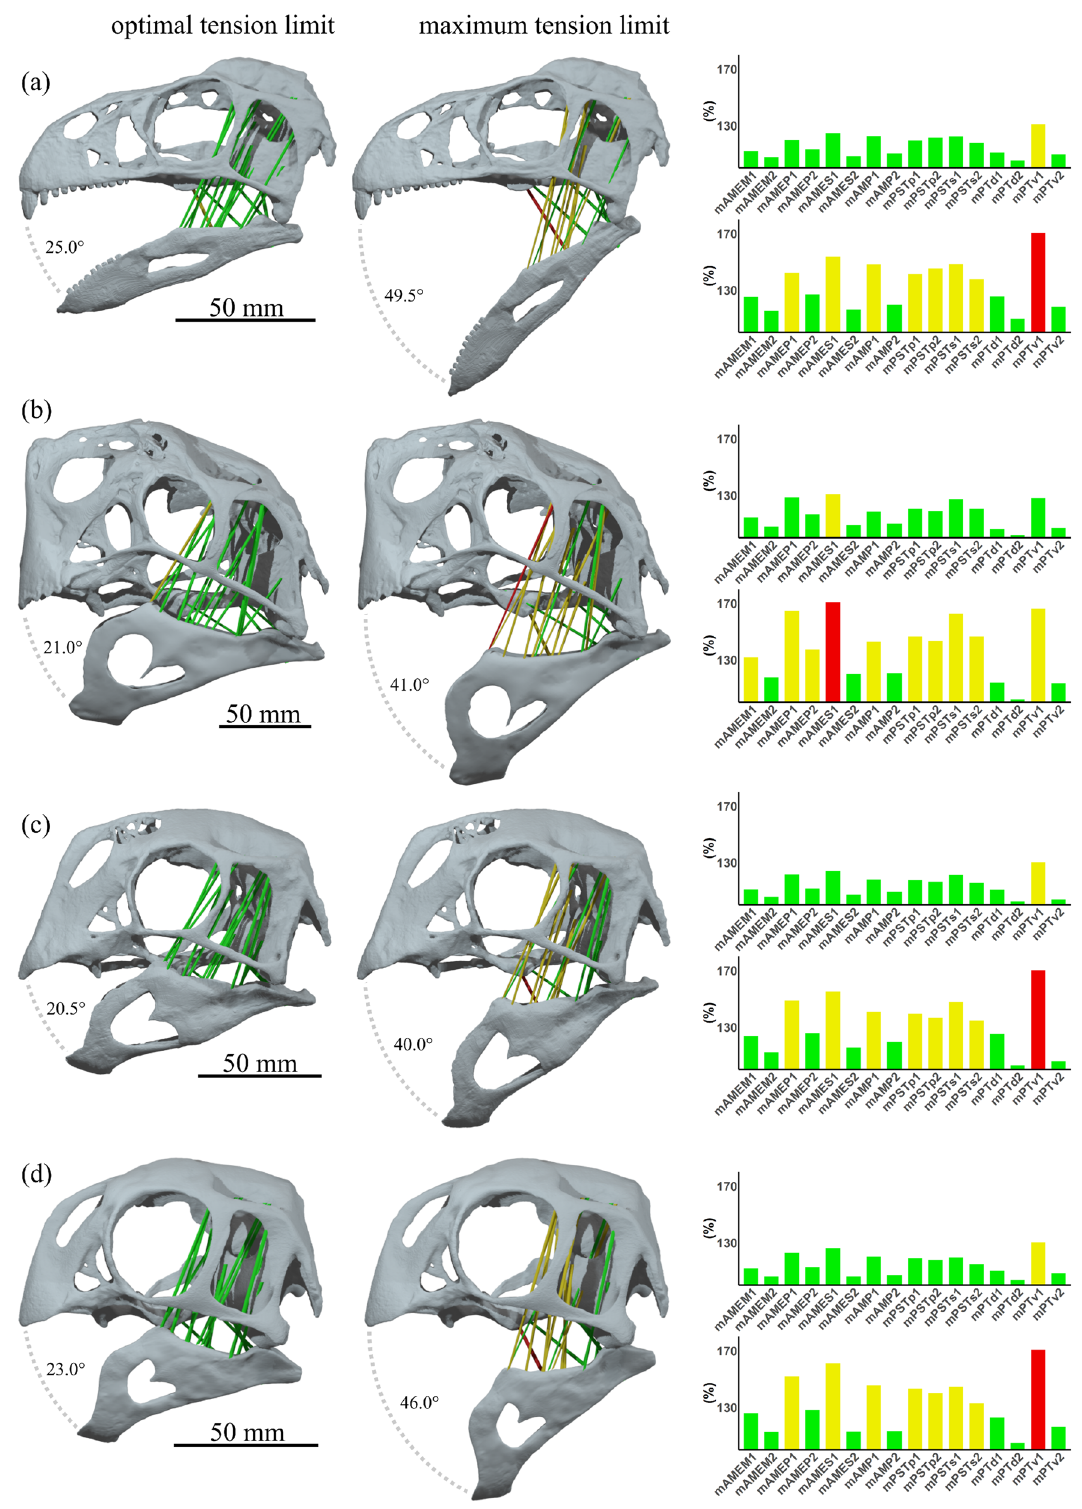
Figure 6. Estimates of the gape angle limit of optimal tension and the maximum limit of gape for muscle tension in Incisivosaurus gauthieri ( a ), Citipati osmolskae ( b ), Khaan mckennai ( c ), and Conchoraptor gracilis ( d ) from a muscle resting length at a gape angle of 5°. Bar charts show the strain factors of individual modelled muscle cylinders at optimal and maximum tension limit; anteriormost muscle cylinders suffixed ‘1’, posteriormost suffixed ‘2’. Muscle cylinders (and corresponding bars) are colour coded yellow and red when exceeding 130% and 170% of resting length respectively, otherwise green. Note that the anterior mPTv constrains gape in all species apart from Citipati which is constrained by the anterior mAMES. Scale bars 50 mm. Muscle abbreviations given in results